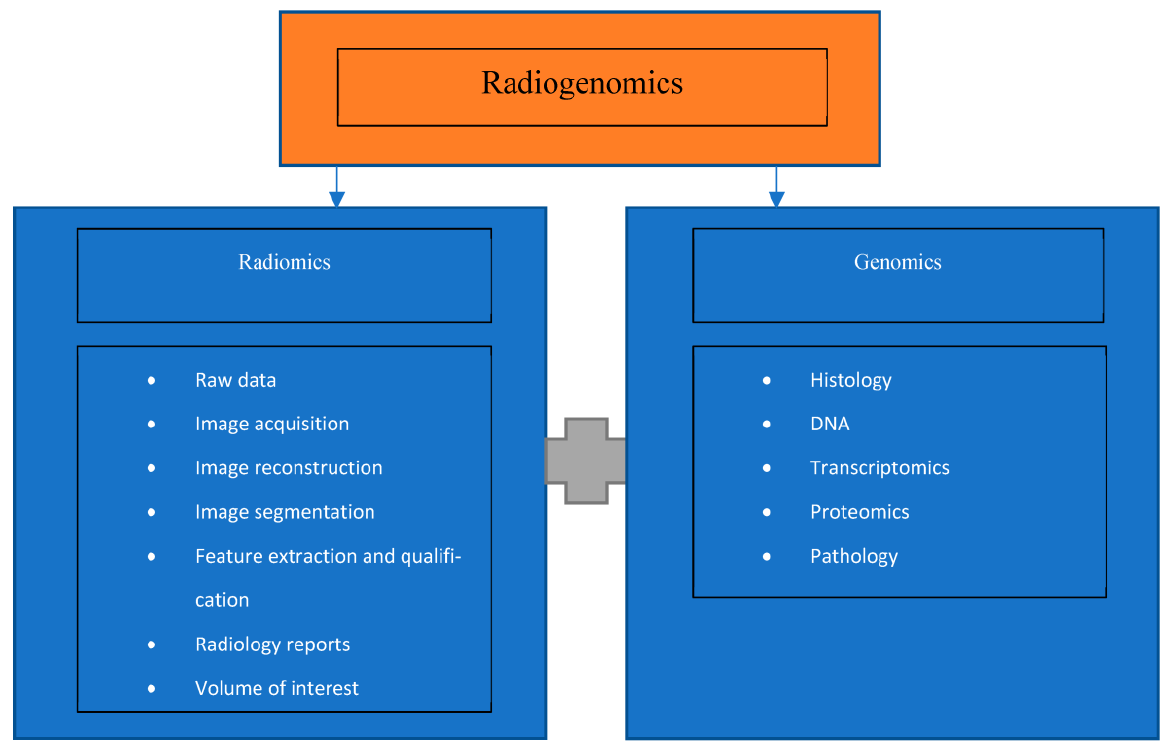
Figure 2. Schematic diagram outlining the aspects of radiogenomics.